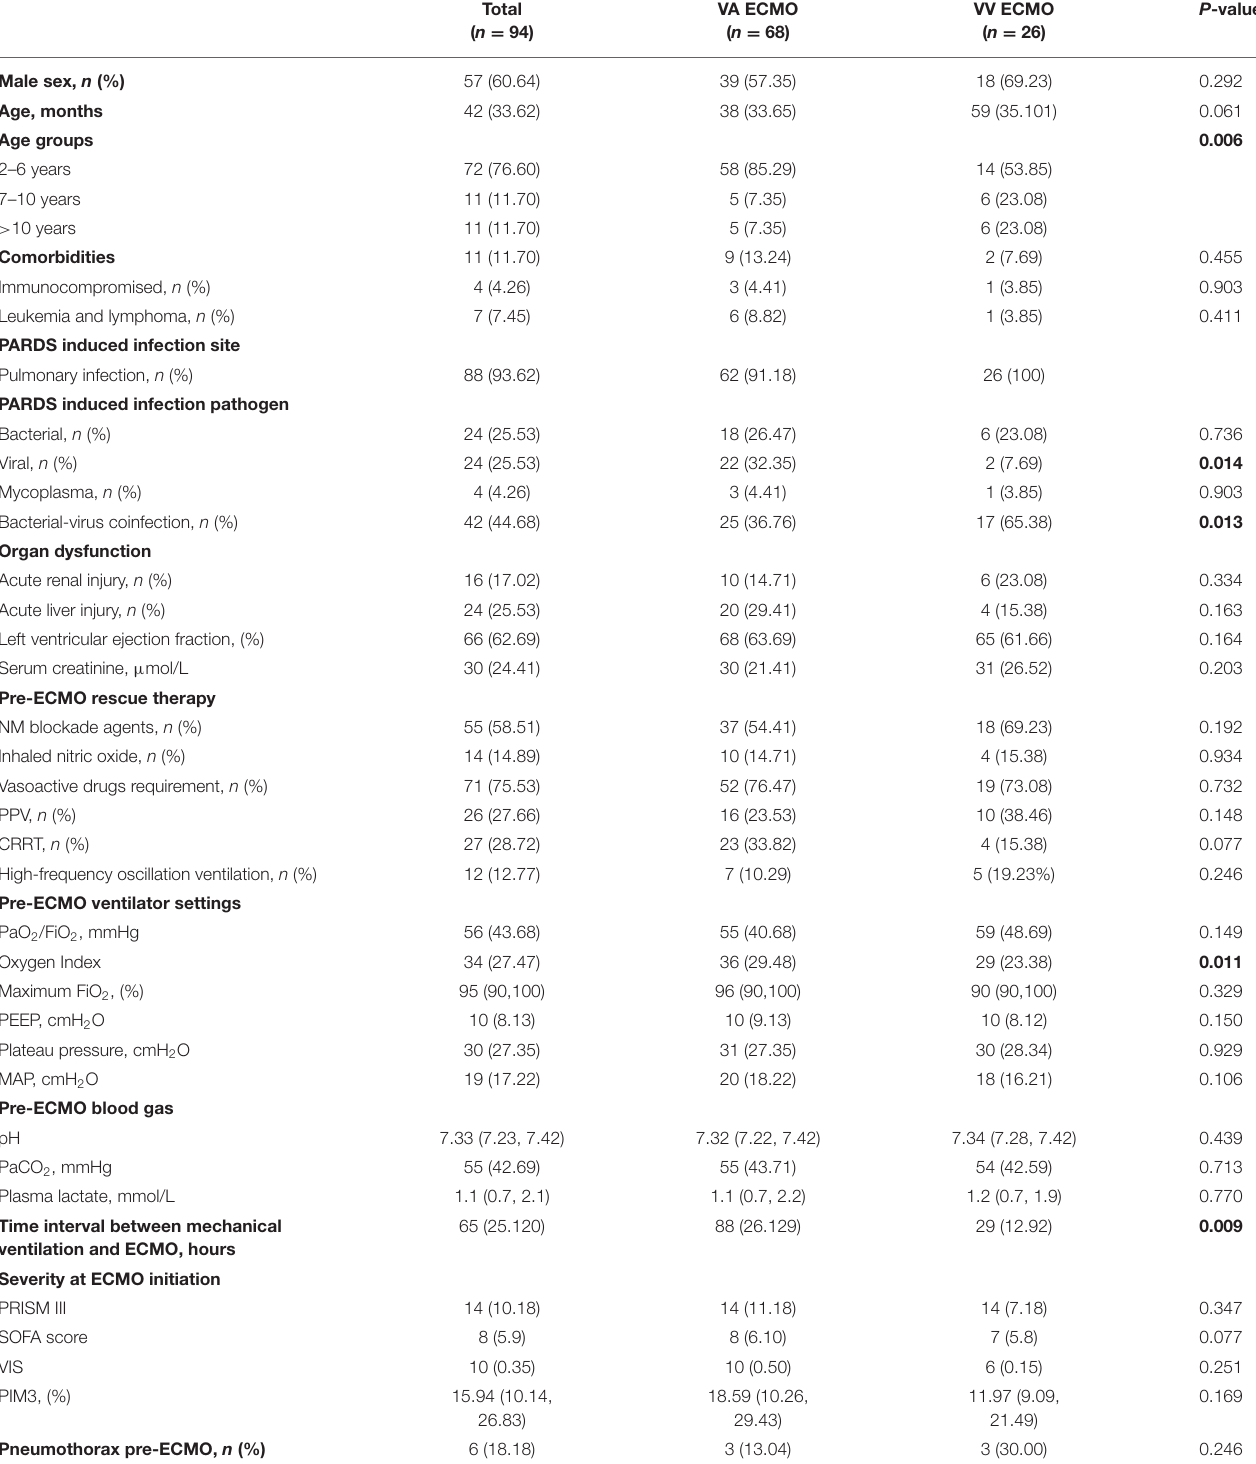
Data are presented as median (IQR) or n (%). Significant values are showing in bold. ECMO, extracorporeal membrane oxygenation; VA, venoarterial; VV, venovenous; PARDS, pediatric acute respiratory distress syndrome; PPV, prone position ventilation;